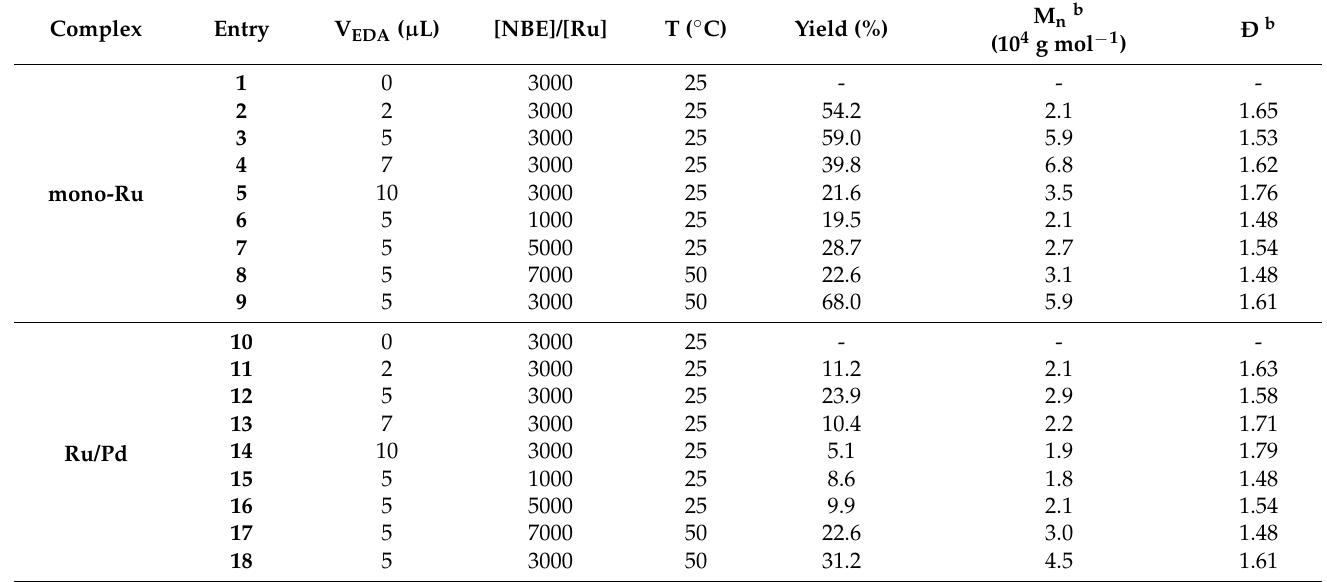
Table 3. ROMP of NBE with mono-Ru and Ru/Pd a